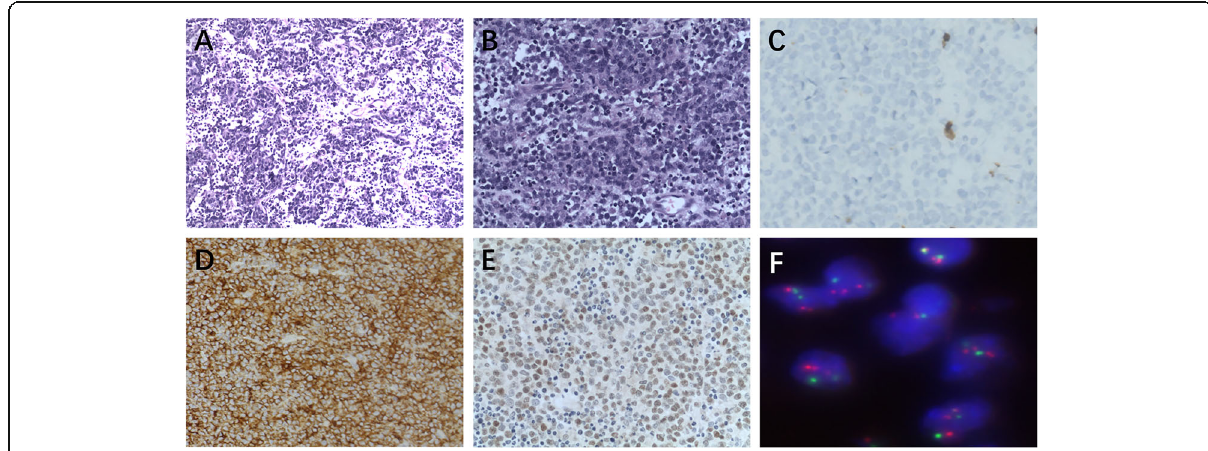
Fig. 3 Burkitt-like lymphomas with the 11q aberration showing low- and high-magnification ( a , b ) not LMO2 expression ( c ) but CD38 and c-Myc expression ( d , e ); Burkitt-like lymphomas with the 11q aberration showed that ATM (11q22.3) was amplified ( f )